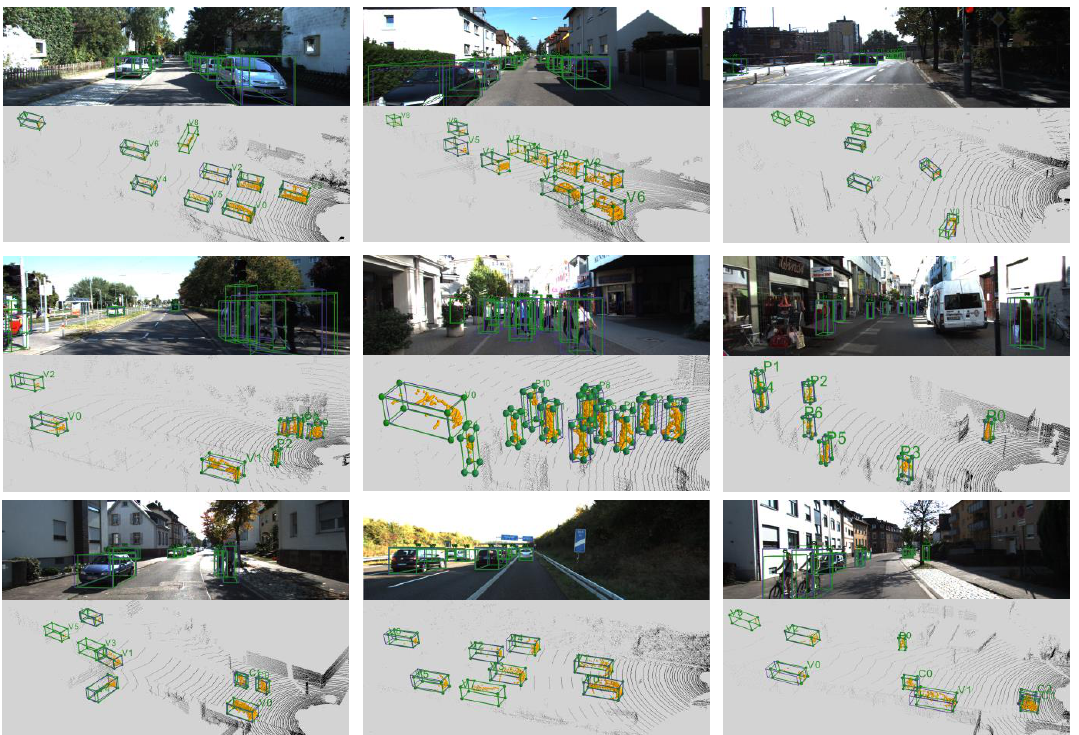
Figure 12. Qualitative results of KDA3D on the KITTI val set. For each sample, the upper part is the image and the lower part is a representative view of the corresponding point clouds. The ground-truth boxes are shown in purple, while the detected objects are shown with green 3D bounding boxes. 3D instance segmentation masks on point clouds are shown in yellow. Digit and letter beside each box denote instance ID and the class, with “V” for car , “P” for pedestrian , and “C” for cyclist . The orientation (driving direction) of each box is specified by the position of the digit and letter. Best viewed in color (zoom in for details). See Section 4.4 for more discussion on the results.